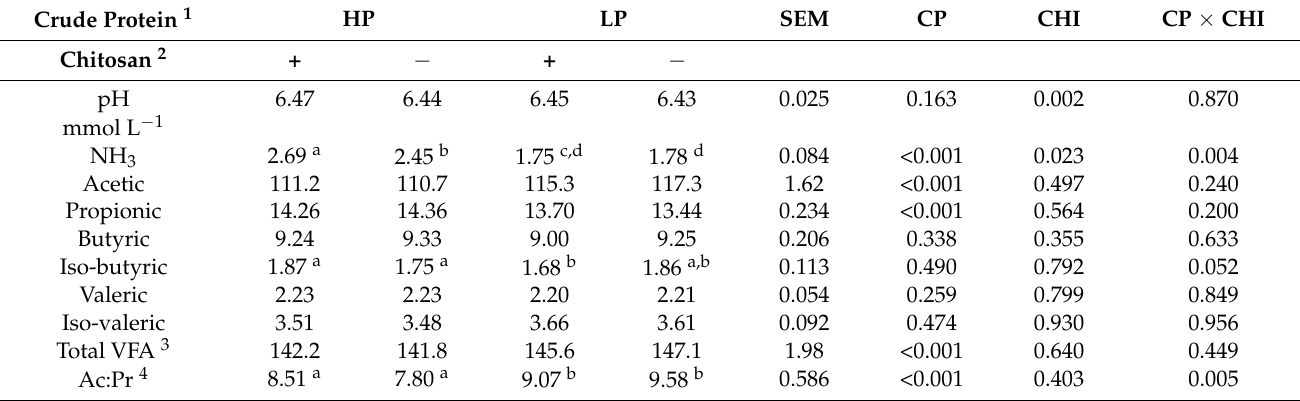
Table 3. Effect of chitosan inclusion and dietary crude protein level on rumen fermentation parameters in beef heifers offered a grass silage-based